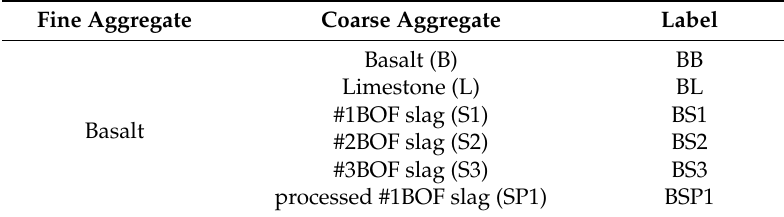
Table 8. Labels for every coarse–fine composition of asphalt mixture.